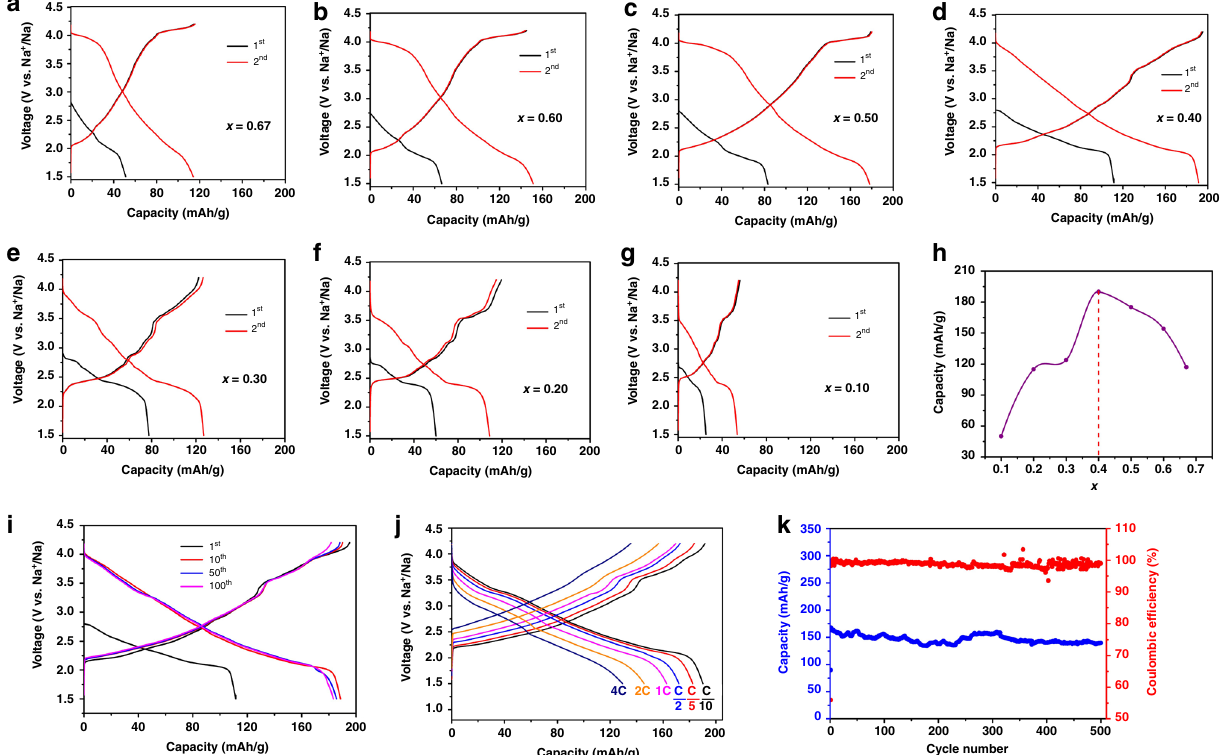
Fig. 3 Sodium storage performance of K x Ni x/2 Mn 1 − x/2 O 2 electrodes. The 1 st and 2 nd discharge/charge curves at C/10 between 1.5 and 4.2 V versus Na + / Na for the material a K 0.67 Ni 0.33 Mn 0.67 O 2 , b K 0.6 Ni 0.3 Mn 0.7 O 2 , c K 0.5 Ni 0.25 Mn 0.75 O 2 , d K 0.4 Ni 0.2 Mn 0.8 O 2 , e K 0.3 Ni 0.15 Mn 0.85 O 2 , f K 0.2 Ni 0.1 Mn 0.9 O 2 , g K 0.1 Ni 0.05 Mn 0.95 O 2 . h Comparison of the 2 nd discharge capacity of K x Ni x/2 Mn 1 − x/2 O 2 versus x . Sodium storage performance of O-P2 K 0.4 Ni 0.2 Mn 0.8 O 2 electrodes: i The 1 st , 10 th , 50 th , and 100 th discharge/charge curves at C/10 between 1.5 and 4.2 V versus Na + /Na. j Rate capability. The capacity versus cycle number at various current rates. k Long-term cycling performance. The capacity and Coulombic ef fi ciency versus cycle number at 1 C. Note that the K content stabilized at 0.08 after fi rst cycle, therefore, the working electrode was Na x K 0.08 Ni 0.2 Mn 0.8 O 2 thereafter.